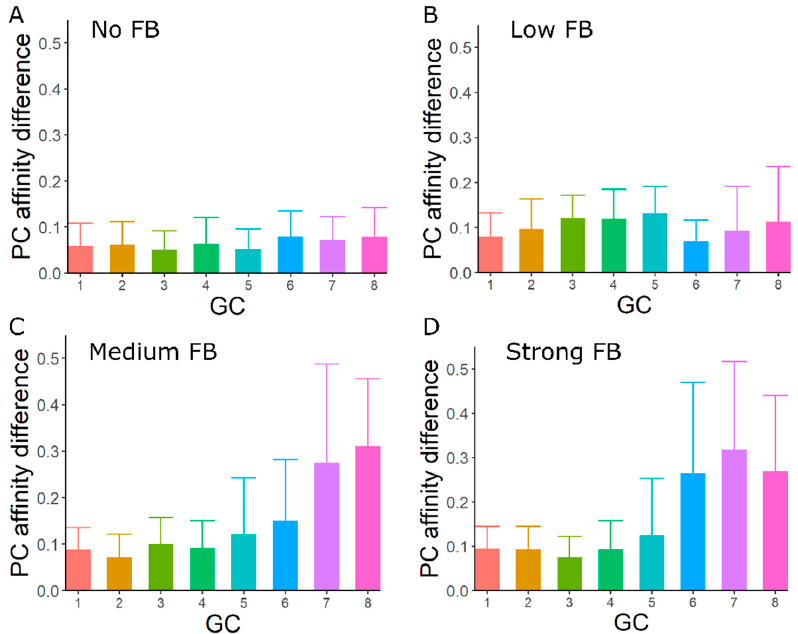
Figure 3. Differences in affinity maturation towards two different epitopes. ( A – D ) Differences in affinity of PCs between two epitopes for different strengths of GC–GC interactions (No FB, Low FB, Medium FB and Strong FB). The PC affinity difference was calculated as the absolute value of the difference between PC affinity to the two different epitopes. GCs were initialized asynchronously with two epitopes in equal proportion (shape space positions 3333 and 5555) and founder cell positions chosen randomly anywhere in the shape space. GCs 1–8 were sorted in the sequence of initiation.